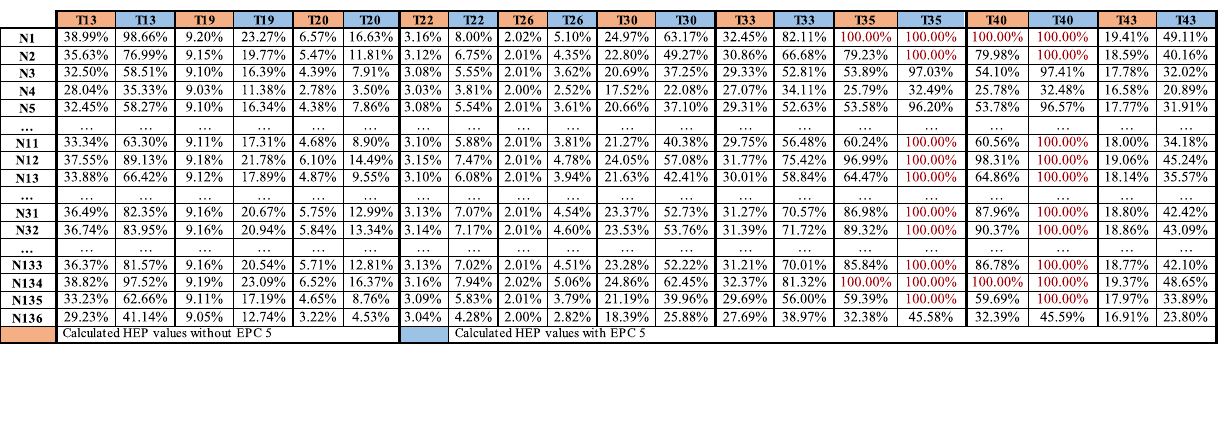
Table 11 HEP values for tasks with and without EPC5